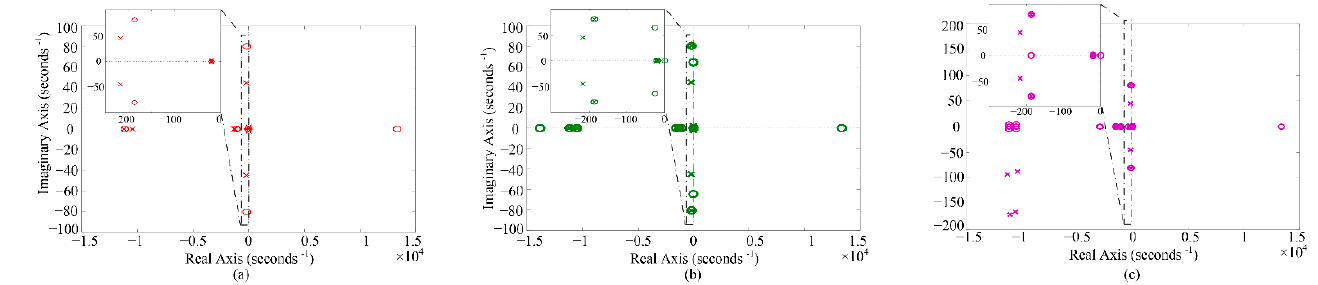
Figure 8. Pole-zero maps of transfer functions without voltage droop: ( a ) G icd _cl ( s ); ( b ) G icd ref_ icq ( s ); ( c ) G icq ref_ icd ( s ).